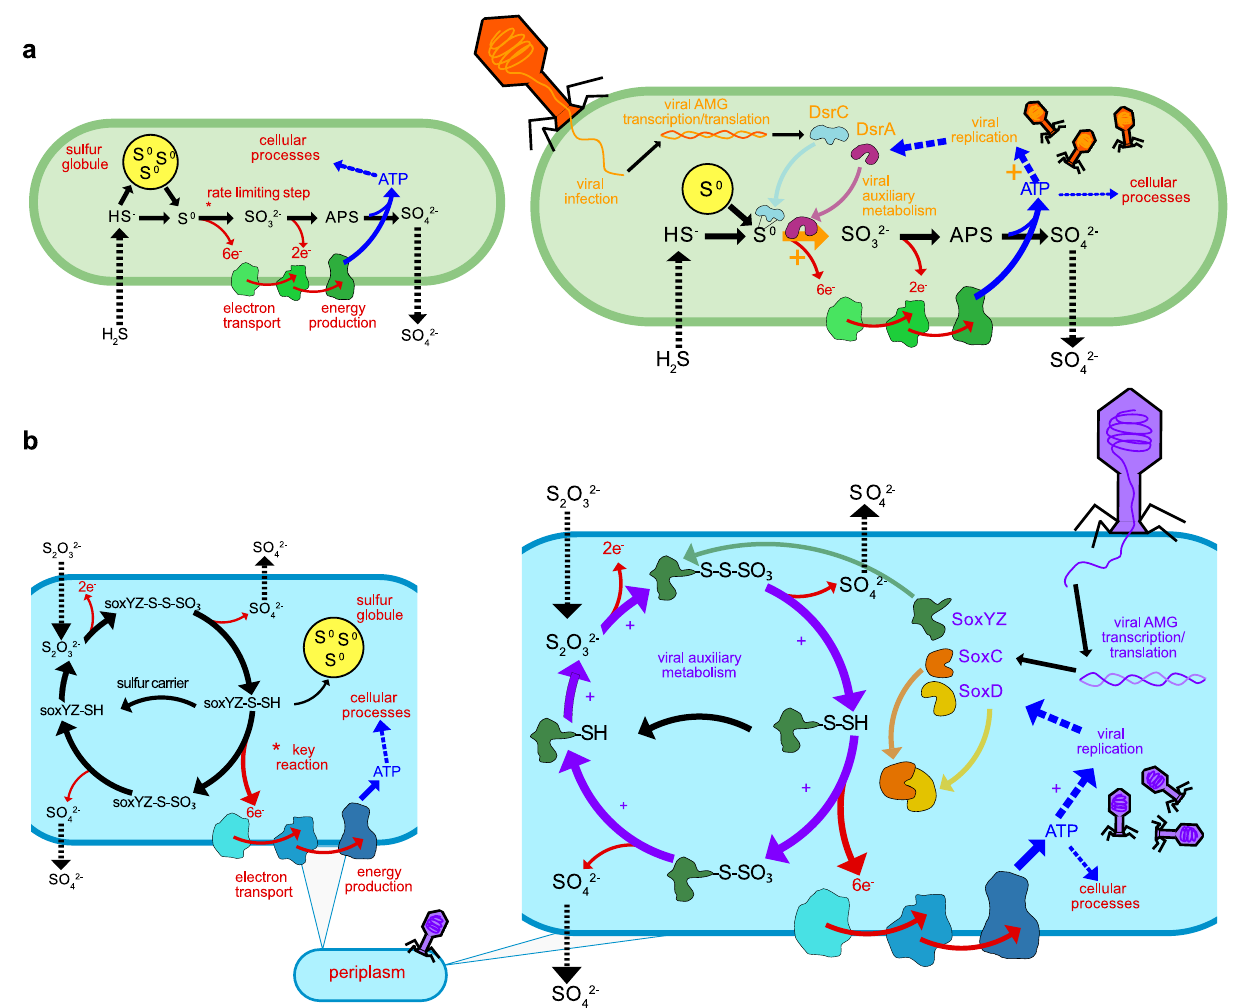
Fig. 2 Conceptual diagrams of viral DsrA, DsrC, SoxC, SoxD, and SoxYZ auxiliary metabolism. a Microbial dissimilatory oxidation of hydrogen sul fi de and stored inorganic sulfur. The resulting production of ATP utilized for cellular processes and growth and the pathway ’ s rate limiting step is indicated with an asterisk (left). Viral infection and manipulation of sulfur oxidation by encoded DsrA or DsrC to augment the pathway ’ s rate limiting step and increase energy yield towards viral replication (right). b Microbial dissimilatory oxidation of thiosulfate or storage of inorganic sulfur in the periplasm. The resulting production of ATP is utilized for cellular processes and the pathway ’ s key energy yielding reaction indicated with an asterisk (left). Viral infection and manipulation of thiosulfate oxidation by encoded SoxC, SoxD, or SoxYZ to augment the entire pathway and the key energy yielding step to increase energy yield towards viral replication (right). For a and b cellular processes are shown in red, sulfur oxidation pathway is shown in black, energy fl ow is shown in blue, and viral processes are shown in orange ( a ) or purple ( b ). For all pathway steps shown, microbial enzymes and sulfur carriers are functional in tandem with viral augmentation. APS: adenosine 5 ’